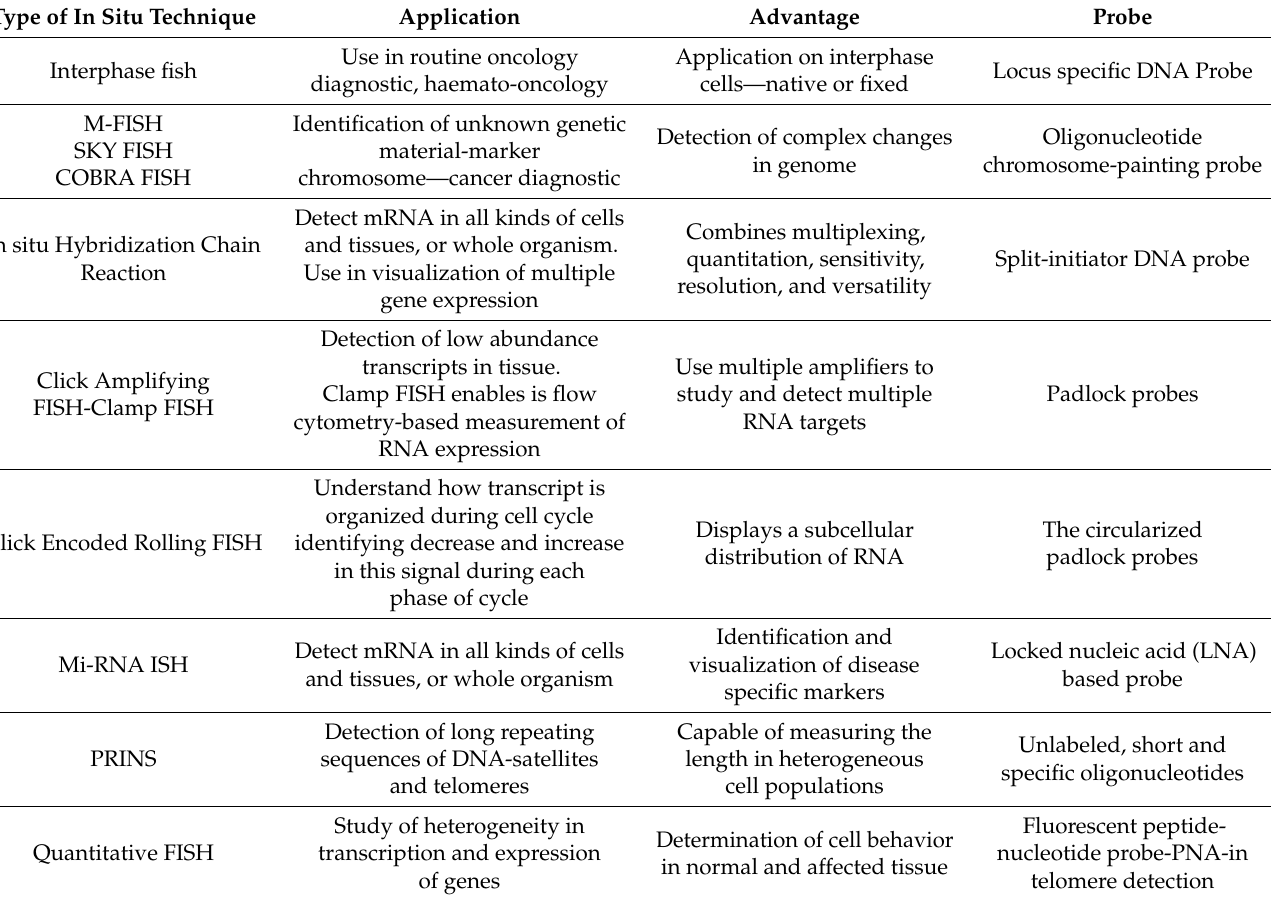
Table 1. Classification of probe depending on labelling